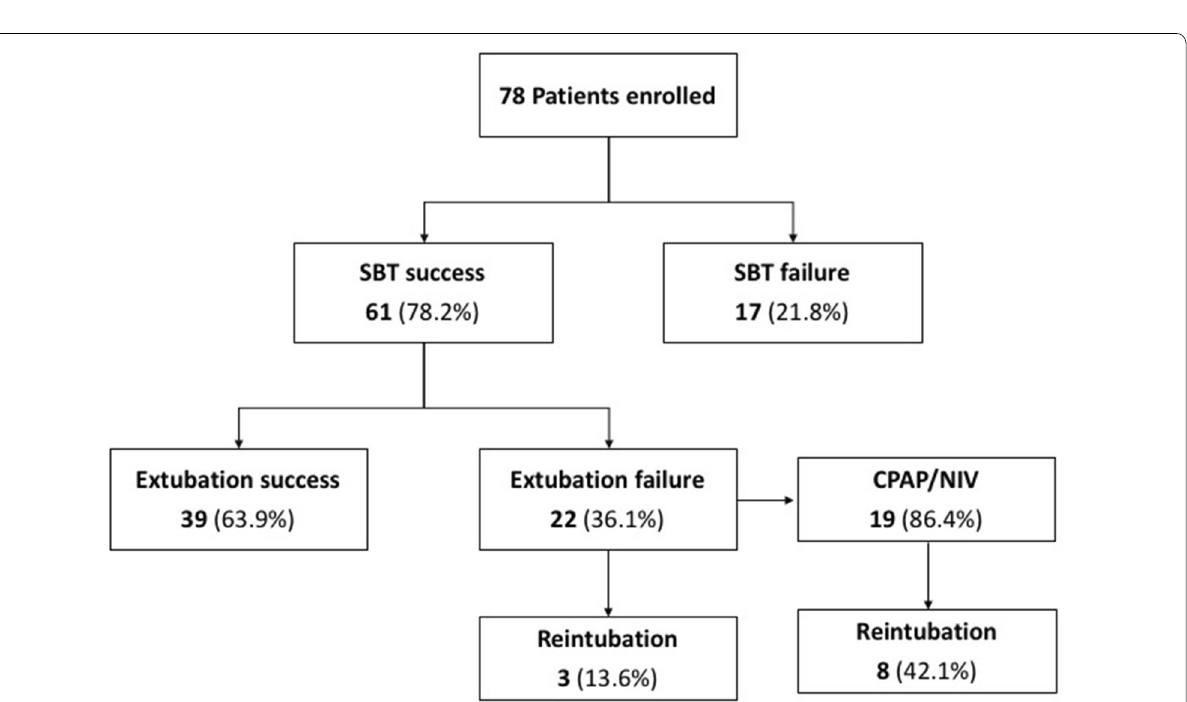
Fig. 1 Patients’ flow throughout the study protocol. Of the overall population of 78 patients who underwent data analysis, 61 patients (78.2%) successfully passed the SBT (i.e., SBT success), whereas 17 (21.8%) did not (i.e., SBT failure). Of the 61 successfully extubated patients, 22 patients (34.9%) met one or more criteria for post-extubation respiratory failure. Among these 22 patients who experienced extubation failure, three individuals (14.9%) required immediate reintubation, while in 19 patients (86.4%) CPAP/NIV was attempted as rescue therapy. Of these 19 patients, 8 (42.1%) failed and were reintubated. Not reported in the figure is that none of the reintubated patients required tracheostomy, and only one patient died 10 days after reintubation because of septic